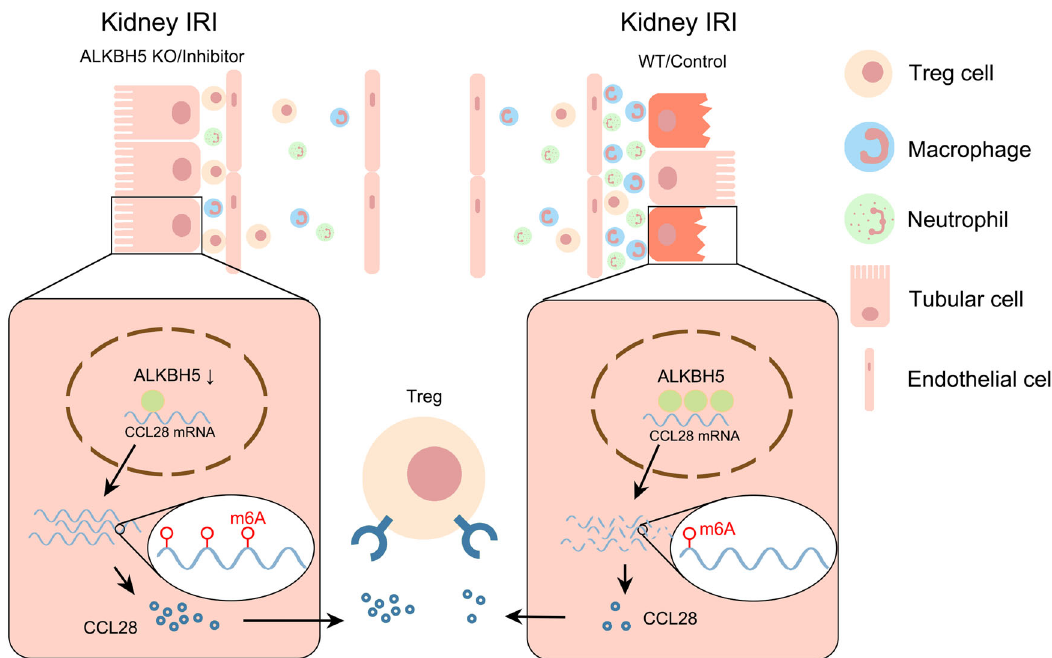
Fig. 9 | Proposed model for this study. Inhibition of ALKBH5 protects I/R-induced kidney injury through increasing CCL28 level by m6A modi fi cation, and regulating downstream CCL28/Treg/in fl ammatory cells